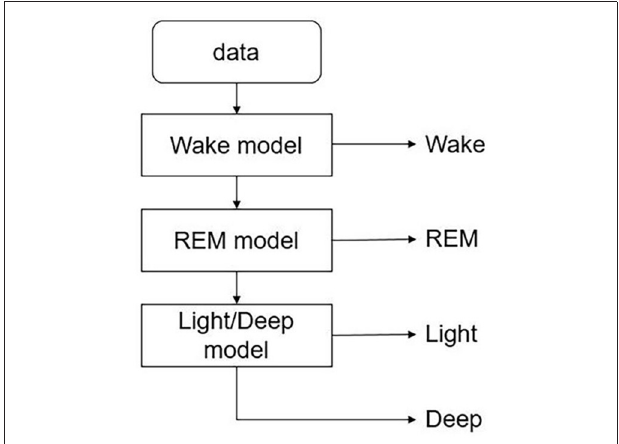
FIGURE 5 | DTB-SVM model for classifying the sleep stages. First, a classifier is used to separate the awake phase and the sleep phase, and then within the sleep phase, the REM phase and the NREM phase are separated, and finally the light sleep and deep sleep are separated by the last classifier.